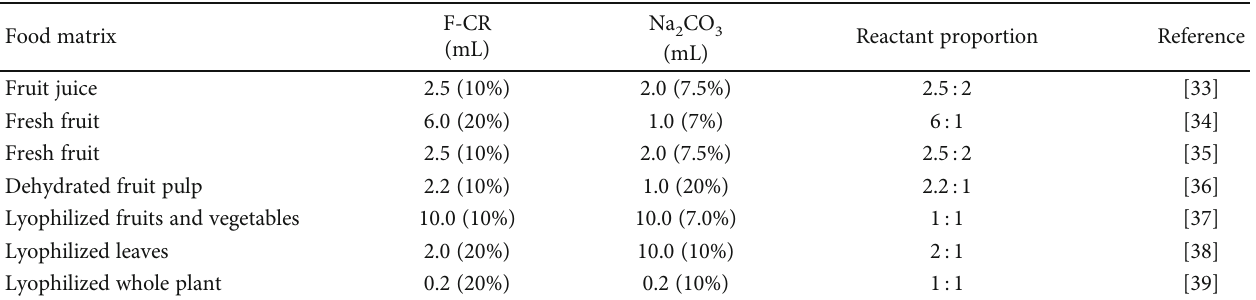
Table 4: F-C reaction parameters (reactants, concentrations, and reactant proportion) applied to di ff erent plant matrices (F-CR, Folin- Ciocalteu